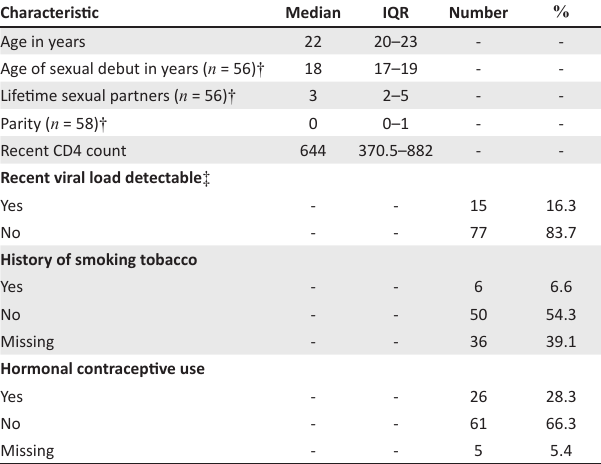
TABLE 2: Characteristics of perinatally HIV-positive youth screened with visual inspection with acetic acid. Characteristic